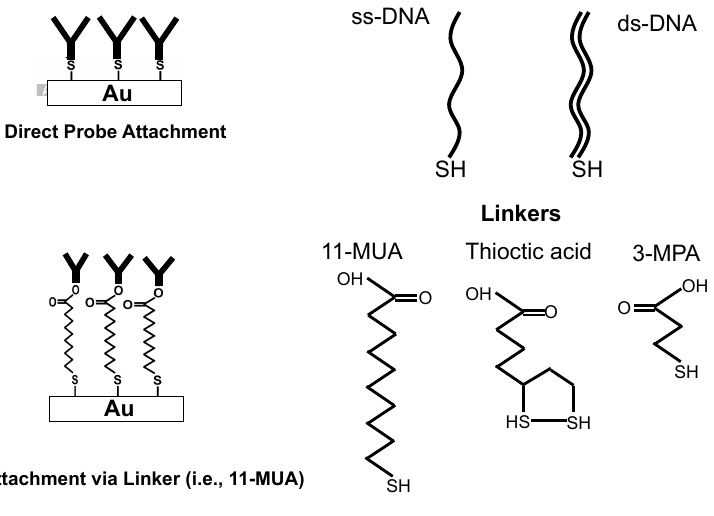
Figure 8. Direct and indirect attachment of molecules onto gold